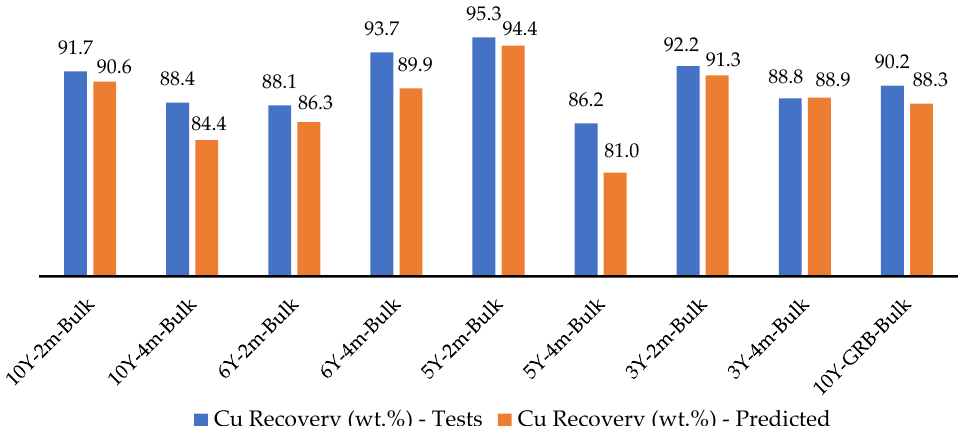
Figure 21. Copper recovery of the flotation tests versus predicted copper recovery based on predic- tions on different size ranges.